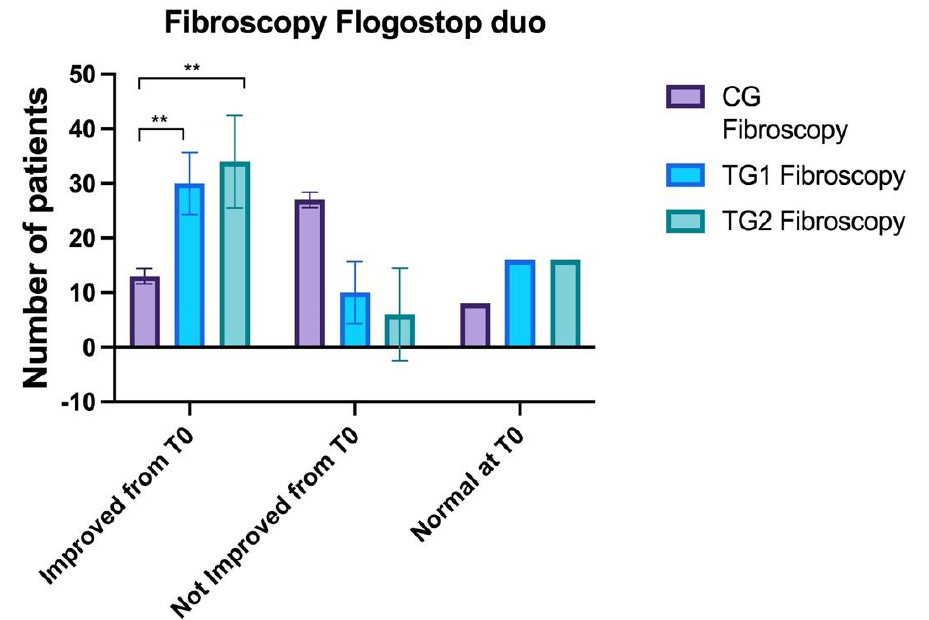
Figure 4. Comparison of the fibroscopy findings between the three groups. Control Groups (CG), Treatment Group 1 (TG1), and Treatment Group 2 (TG2). Standard deviation “I”. The asterisk “**” indicates p < 0.01.